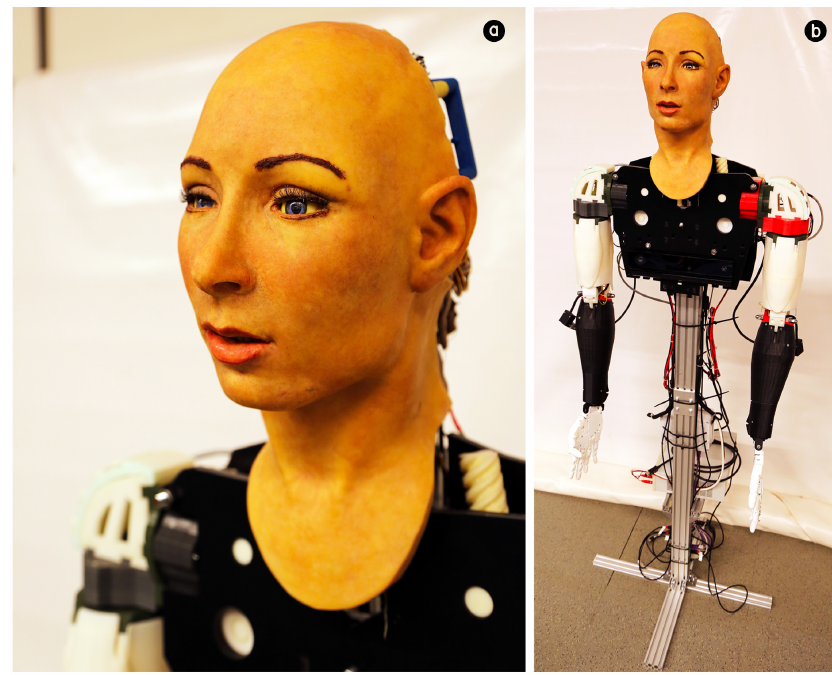
Figure 4. The FACE Robot and its novel body; ( a ) a close-up portrait; ( b ) a full-body portrait.